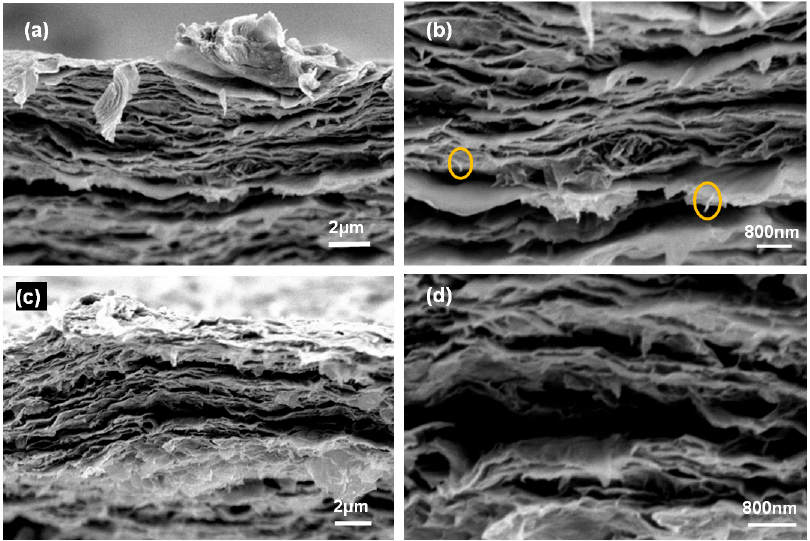
Figure 6. Torn cross-sections of membranes with ( a , b ) 30 and ( c , d ) 50 wt.% graphene.